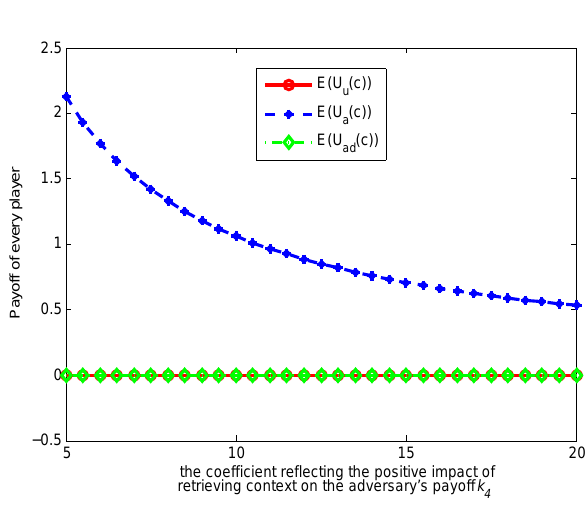
Figure 5. Impact of k 4 on strategies.